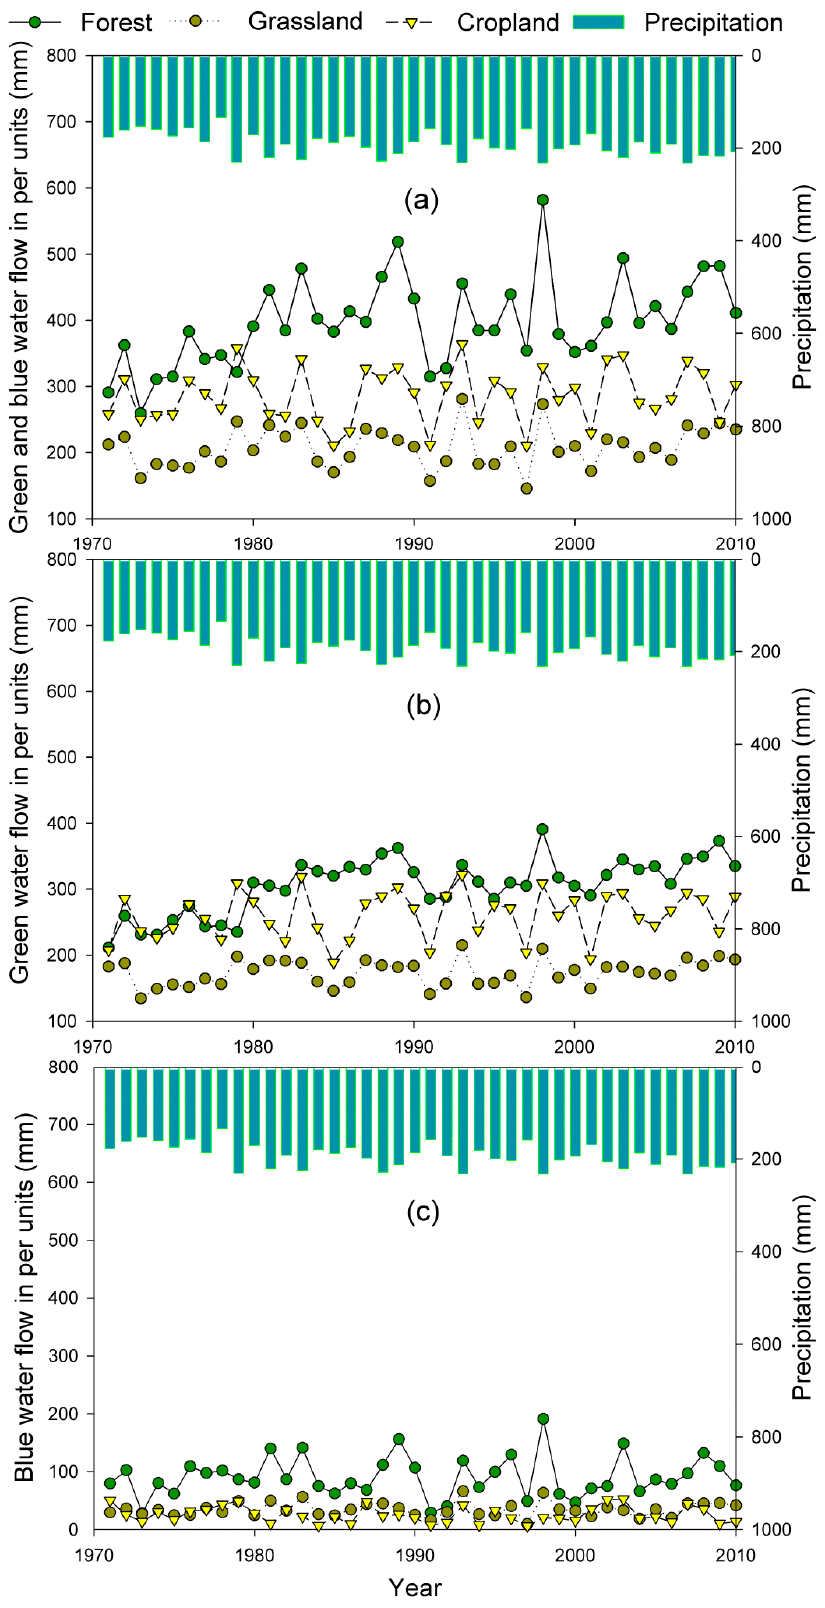
Figure 3. Green and blue water flow in terms of per units of the typical ecosystem. ( a ) is green and blue water flow in per units, ( b ) is green water flow in per units, ( c ) is blue water flow in per